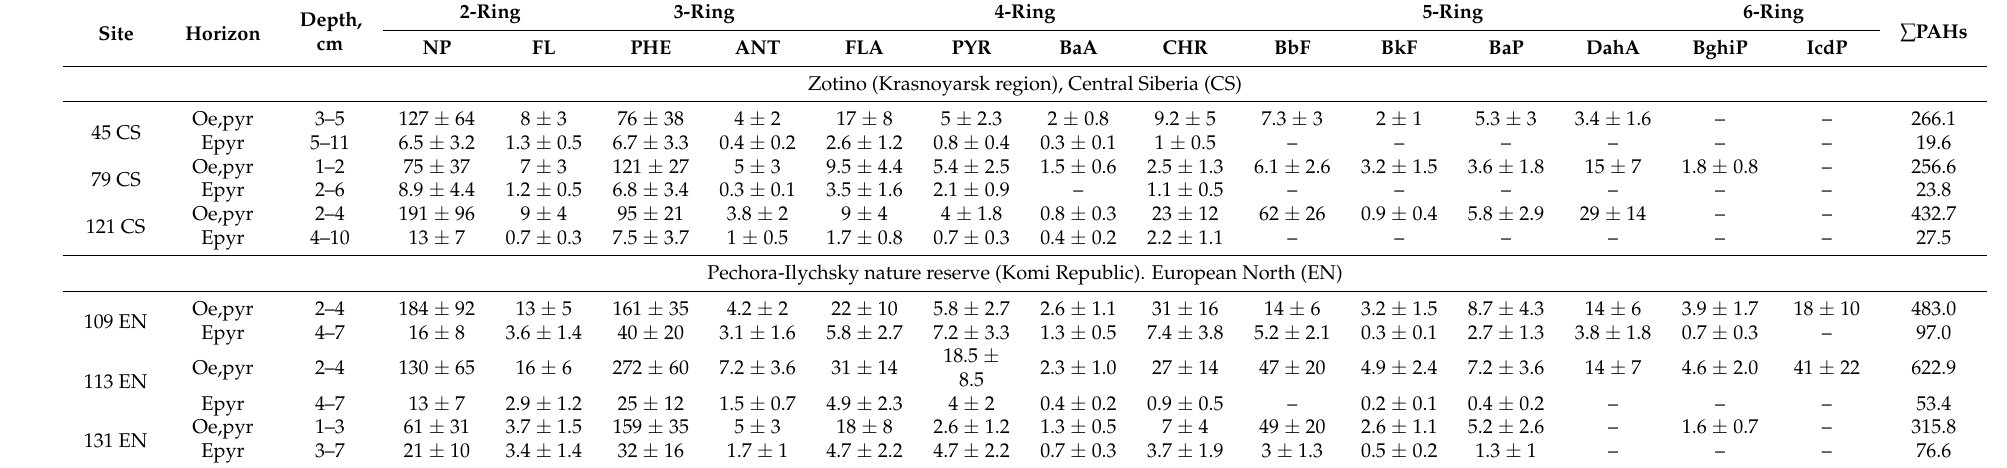
Table 3. PAH content in the upper soil horizons (x ± δ ), ng g − 1